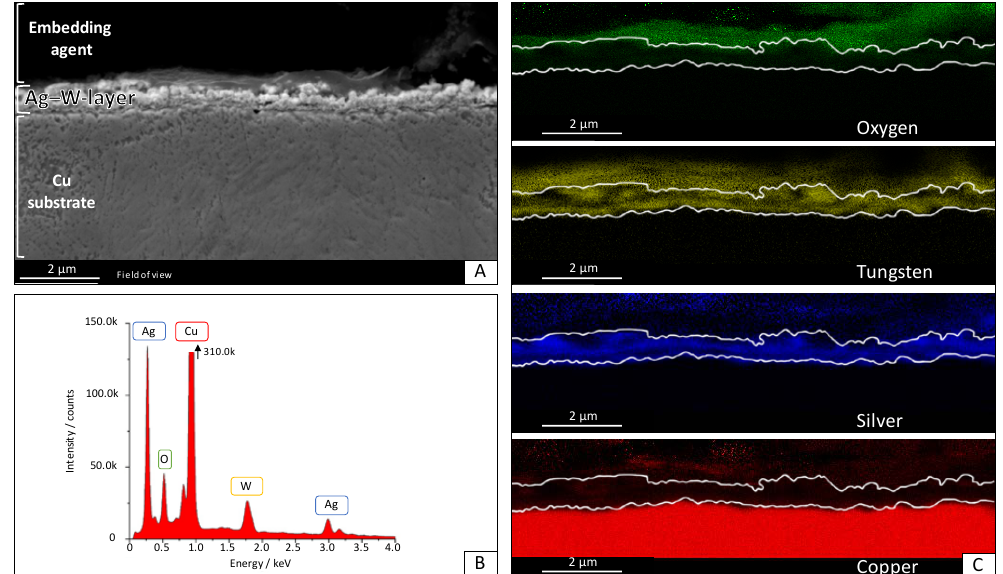
Figure 4. Scanning electron microscopy (SEM) image of the Ag–W film with w W = 50% ( x W = 36.9%) W ( A ) with EDS area measurement of the layer ( B ) and the element-mapping that shows the distribution of O, Cu, Ag, and W ( C ).